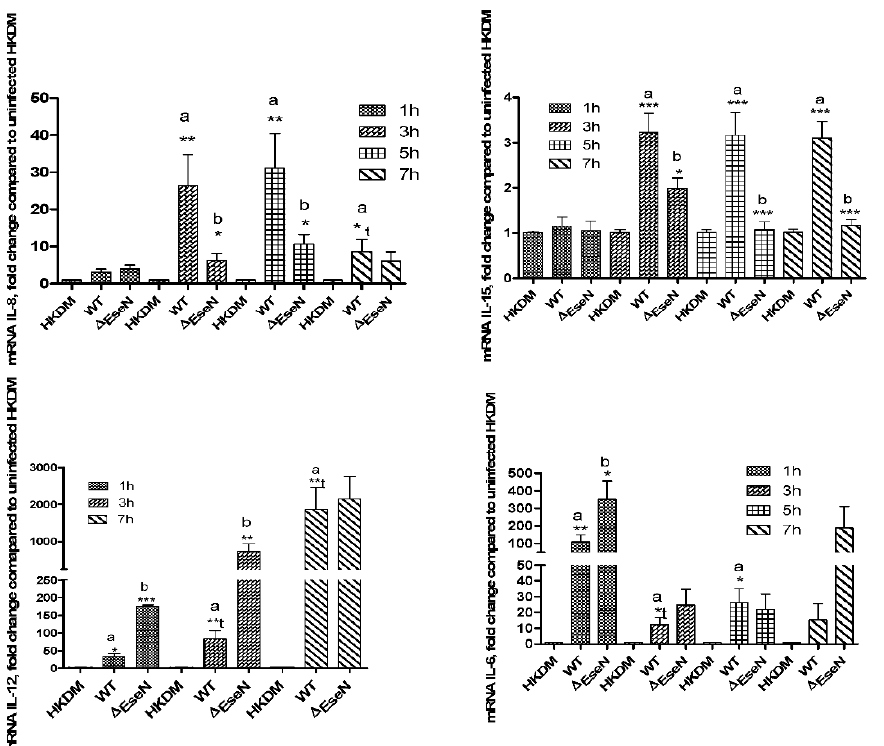
Figure 5. Cytokines expression detected by RT-qPCR. Data were analyzed by Rosh LightCycler ® 96 qPCR software using relative expression method. CanX and SDHA were used as reference genes. Comparison between groups was based on One-way ANOVA with the Bonferroni procedure for comparison of group means. Each column represents the mean ± SE of 3 to 4 independent experiments. Comparison between two groups was also analyzed by t -test (t); a: indicates significant difference between HKDM-WT (WT) and not infected HKDM (HKDM), b: indicates significant difference between HKDM-WT (WT) and HKDM- ∆EseN (∆EseN). * p < 0.05, ** p < 0.01, *** p < 0001.